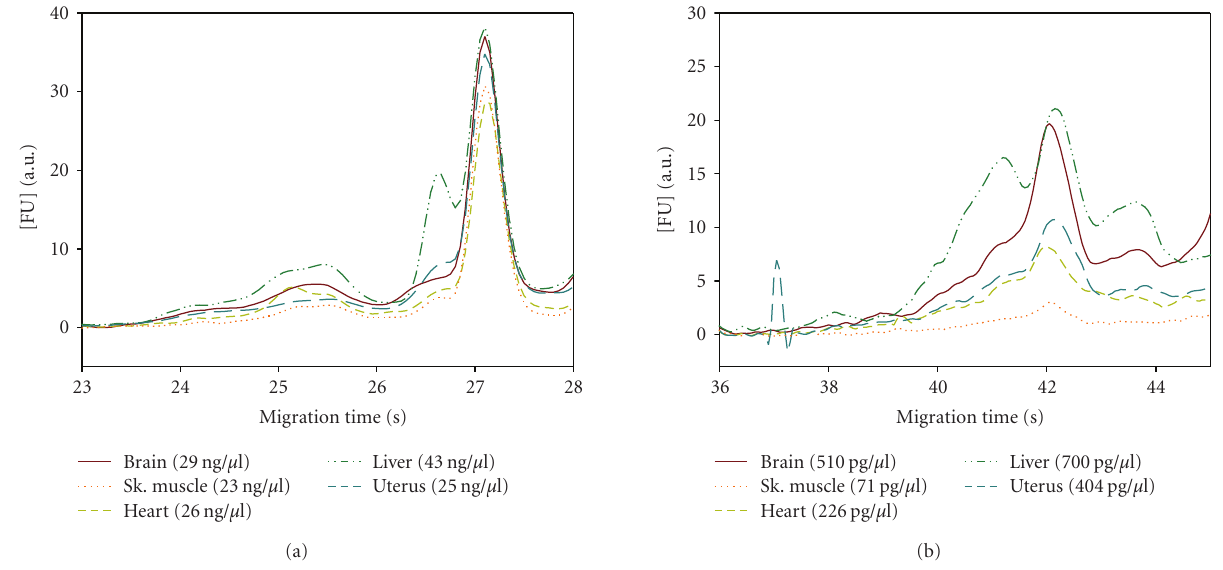
Figure 5: (a) Electropherogram profile of LMW RNA species of five di ff erent tissues (brain, skeletal muscle, heart, liver, and uterus). (b) Electropherogram profile of miRNA species of the same tissues.